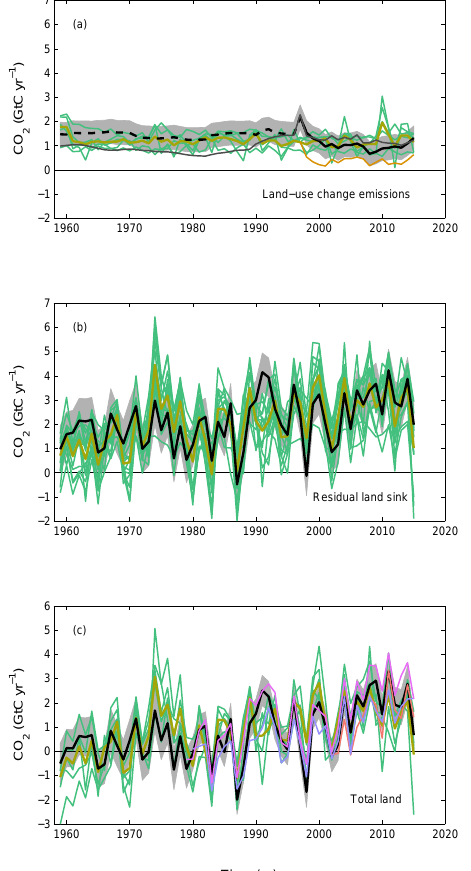
Figure 6. CO 2 exchanges between the atmosphere and the terres- trial biosphere. (a) Comparison of the global carbon budget values of CO 2 emissions from land-use change ( E LUC ; black with ± 1 σ uncertainty in grey shading), with CO 2 emissions from land-use change showing individual DGVM results (green) and the multi- model mean (olive), as well as fire-based results (orange); land-use- change data prior to 1997 (dashed black) highlights the pre-satellite years; preliminary results using the FAO FRA 2015 (Houghton and Nassikas, 2016) are also shown in dark grey. (b) Land CO 2 sink ( S LAND ; black with uncertainty in grey shading) showing individ- ual DGVM results (green) and multi-model mean (olive). (c) Total land CO 2 fluxes ( b–a ; black with uncertainty in grey shading), from DGVM results (green) and the multi-model mean (olive), and atmo- spheric inversions Chevallier et al. (2005; CAMSv15.2) in purple; Rödenbeck et al. (2003; Jena CarboScope, s81_v3.8) in violet; Pe- ters et al. (2010; Carbon Tracker, CTE2016-FT) in salmon; and the carbon balance from Eq. (1) (black). Five DGVMs are plotted in (a) and 14 in (b, c) ; see Table 5 for the list and Table 6 for the descrip- tion. In (c) the inversions were corrected for the pre-industrial land sink of CO 2 from river input by removing a sink of 0.45GtCyr − 1 (Jacobson et al., 2007). This correction does not take into account the anthropogenic contribution to river fluxes (see Sect. 2.7.2).